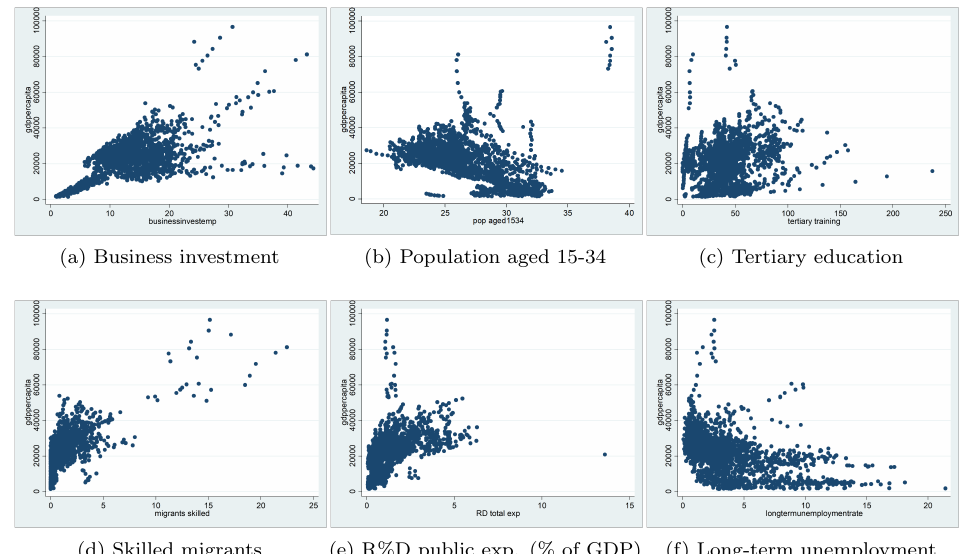
Figure 5: Correlations between GDP per capita (vertical axis) and selected factors